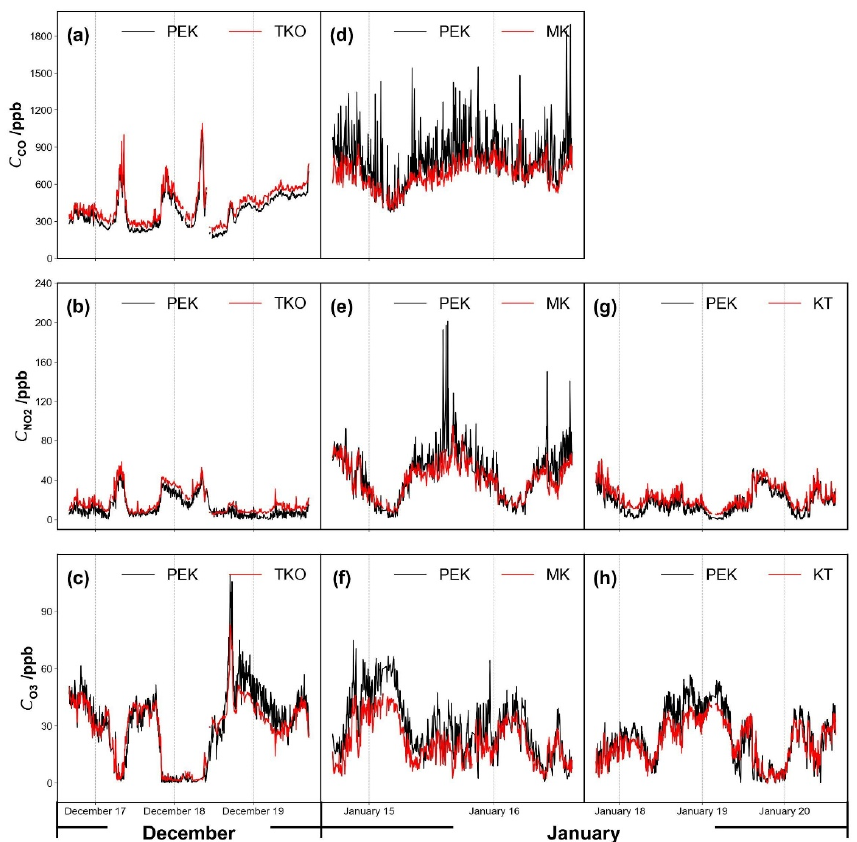
Figure 5. Time series plots for gases measured by the Personal Exposure Kit (PEK), calibrated under laboratory conditions (Methodology 2.3.1 (I)) as validated at the ( a – c ) Tseung Kwan O (TKO), ( d – f ) Mong Kok (MK) and ( g , h ) Kwun Tong (KT) air quality monitoring sites. Note: CO for Kwun Tong site was not available. Data resolution is set as 5 min.